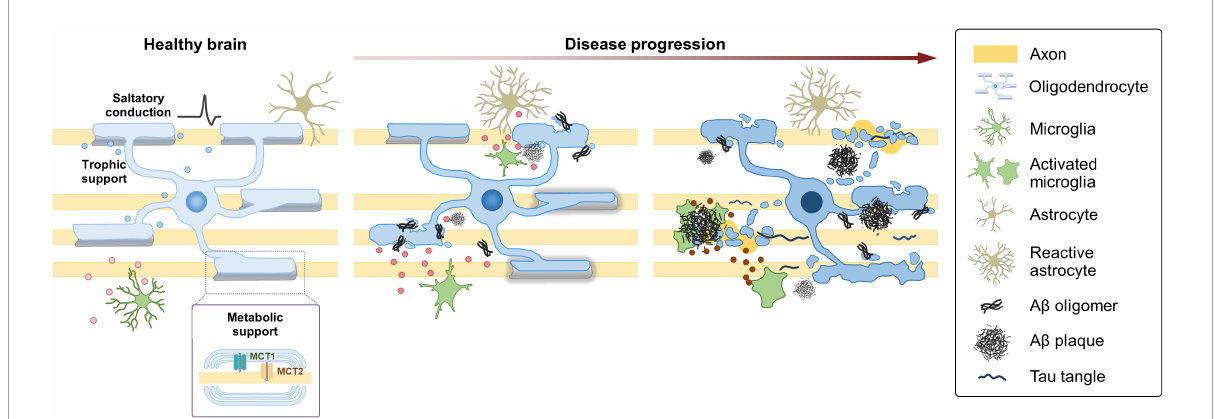
FIGURE2 Dynamic changes of oligodendroglia during the progression of AD. Under healthy conditions, OLs enable saltatory conduction of electrical signals and provide metabolic and trophic support to neurons. In the AD brain, OLs are vulnerable to neurodegenerative conditions and acquire a distinct cellular state in response to the changing microenvironment. Under mild A β exposure, OLs alter gene expression and start to exhibit myelin defects. As the disease progresses, defects in OL function and myelin loss become more evident in correlation with the increased A β burden. Perturbation of myelin-axon coupling affects signal propagation as well as metabolic and trophic support. At later stages with higher A β burden, a specific subgroup of OLs express C4b and Serpina3n . Some aspects of the late-stage OLs might be shared across several NDDs. As AD progresses, microglia also become destructive by releasing neurotoxic inflammatory mediators, such as cytokines, chemokines, and reactive oxygen and nitrogen species. The changing state of microglia, reflected in part, by their secretory profile, might play a crucial role in the progression of